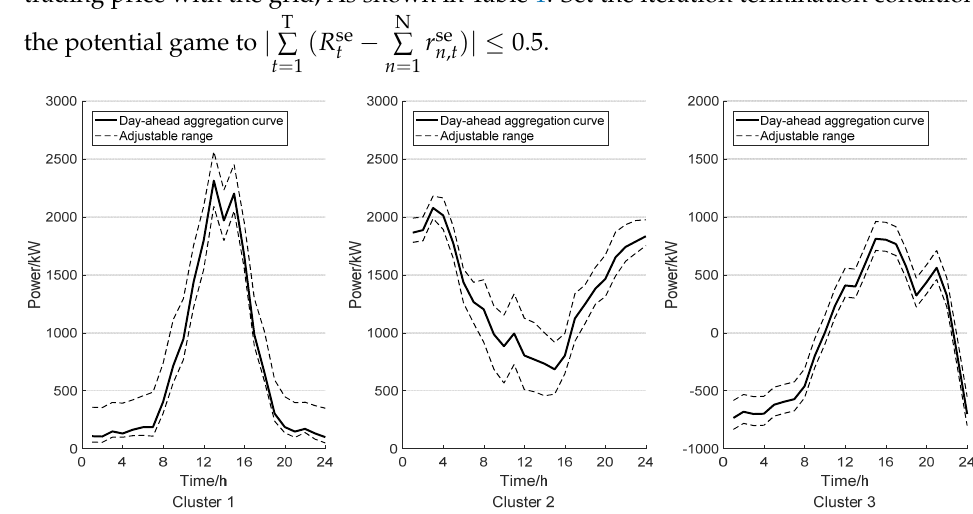
Table 1. Electricity trading prices of each cluster.